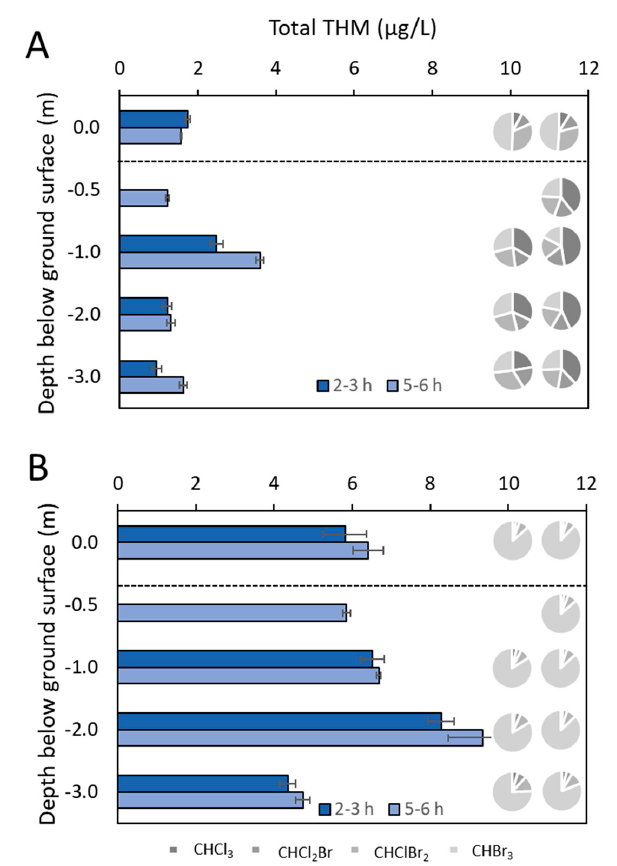
Figure 1. Total trihalomethanes (THMs, blue bars) along the vadose zone for ( A ) chlorinated desalinated seawater (DSW); and ( B ) DSW spiked with bromide (2045 ± 205 µg/L). At each depth a water sample was taken twice along the experiment, except for the 0.5 m point. The error bars represent the standard deviation between three sequentially collected samples at each sampling phase. The dashed line illustrates the interface between the surface water and the vadose zone. The distribution of the THM species in each depth (averages for three subsequent samples) is presented in pie plots, with chloroform presented as dark gray, and colors gradually become lighter with the replacement of chlorine substituents with bromine (concentrations are provided on the Supplementary Materials).